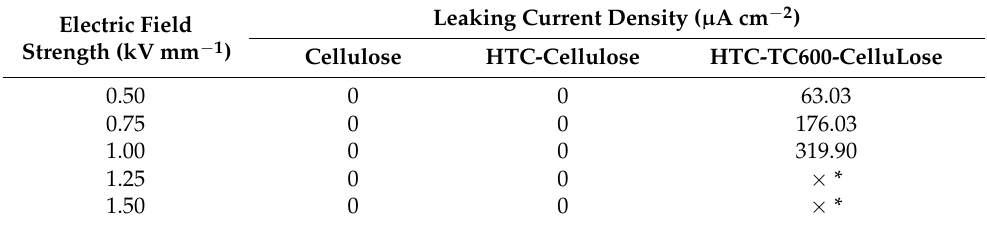
Table 1. Leaking current density of the prepared ER fluids.